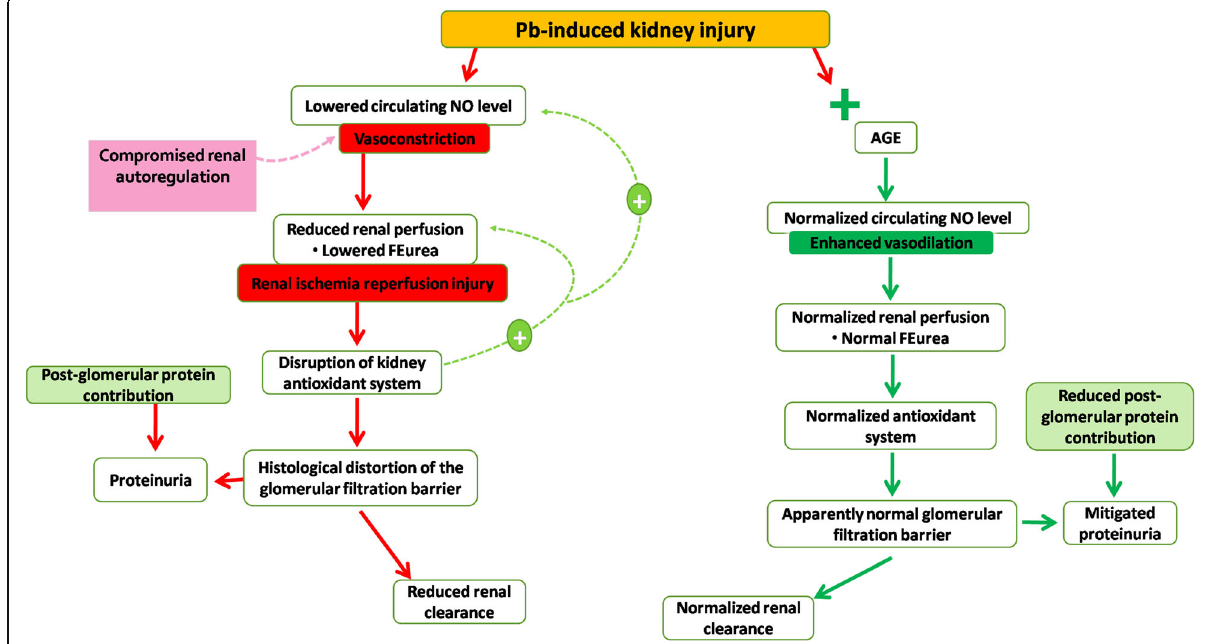
Fig. 5 Apparent mechanism of Pb-induced kidney injury and the effects of AGE on the mechanism of action. + = positive feedback mechanism; Pb = lead acetate; AGE = aqueous garlic extract; NO = nitric oxide; FEurea = fractional excretion of